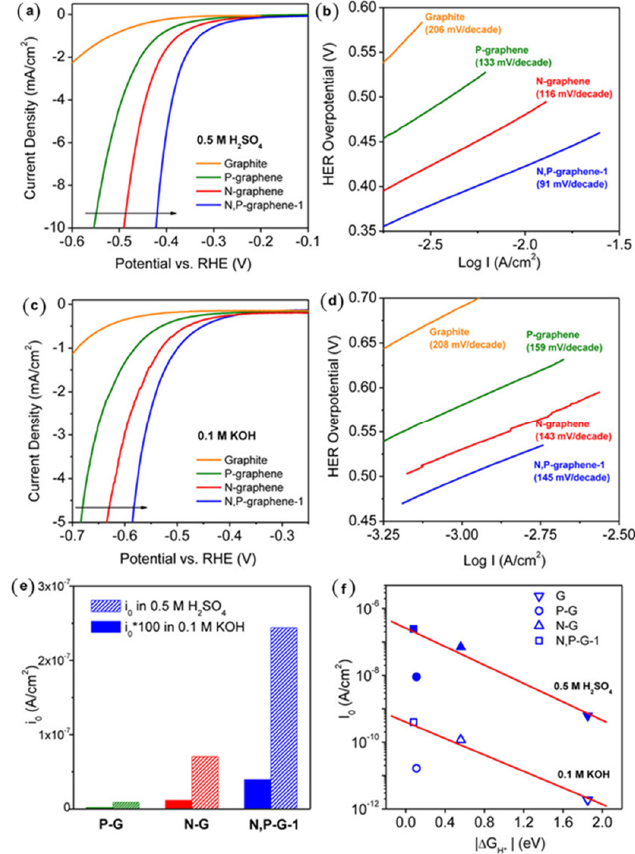
Figure 6. HER polarization curves and respective Tafel plots of N − and/or P − doped graphene electrocatalysts in ( a , b ) 0.5 M H 2 SO 4 (pH = 0) and ( c , d ) 0.1 M KOH (pH = 13). ( e ) The calculated values of i0 for N and/or P − doped graphene in 0.5 M H 2 SO 4 (patterned bars) and 0.1 M KOH (solid bars) solutions are compared (*100 is 100 times than original data). ( f ) Relationship between exchange current density (I 0 ) and free energy ( Δ G H* ) of N − and/or P − doped graphene. Reprinted with permission from Ref. [131]. Copyright 2014 American Chemical Society.